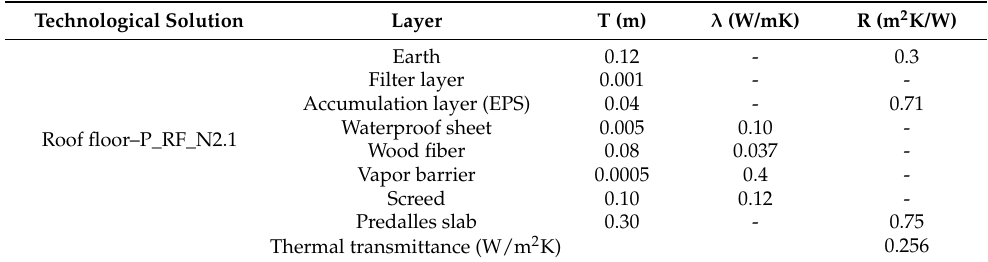
Table A15. Possible redevelopment measure for roof floor with green roof as the finishing layer (P_RF_N2.1).